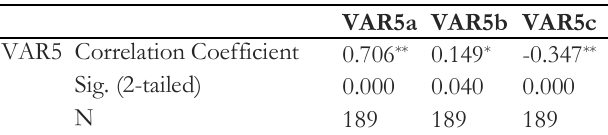
Table 10. Correlation among neutrosophic item 5 and classical item 5.